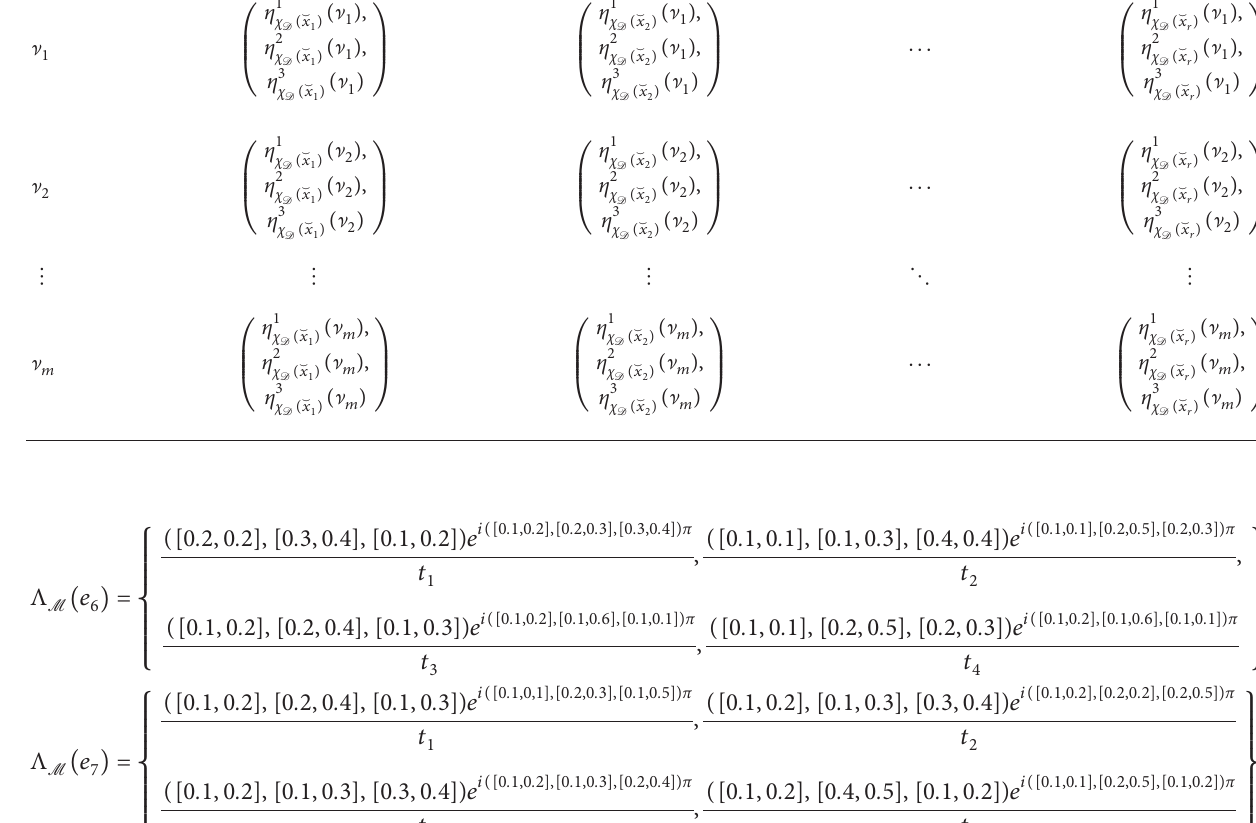
Table 5: Tabular representation of ξ